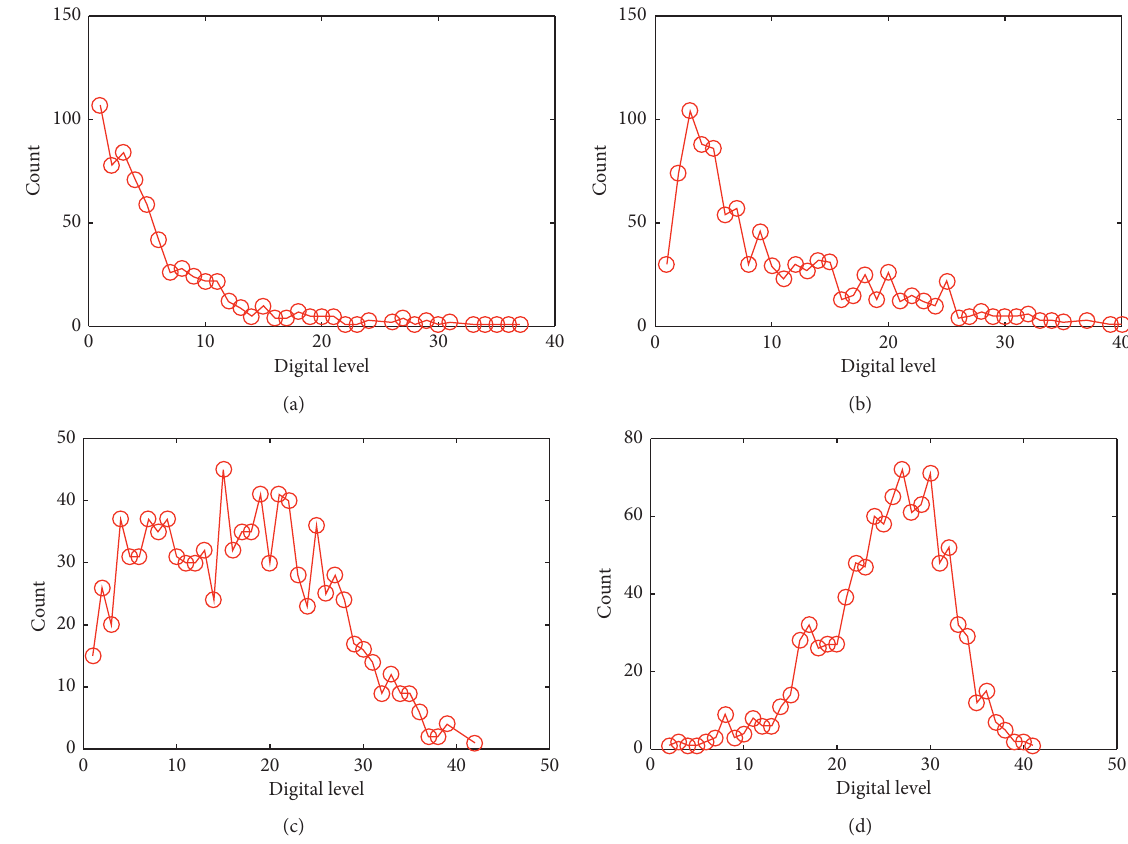
Figure 3: Digital level distribution of enterprises under different transformation costs: (a) Cu � 2, Cb � 4; (b) Cu � 1.5, Cb � 3; (c) Cu � 1, Cb � 2; (d) Cu � 0.5, Cb �